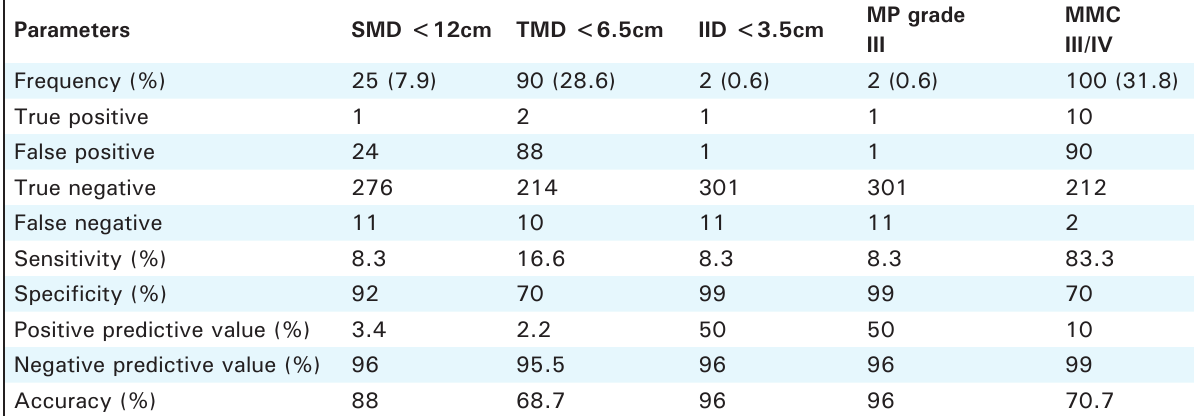
Table 2. Statistical values of predictors for difficult laryngoscopy.